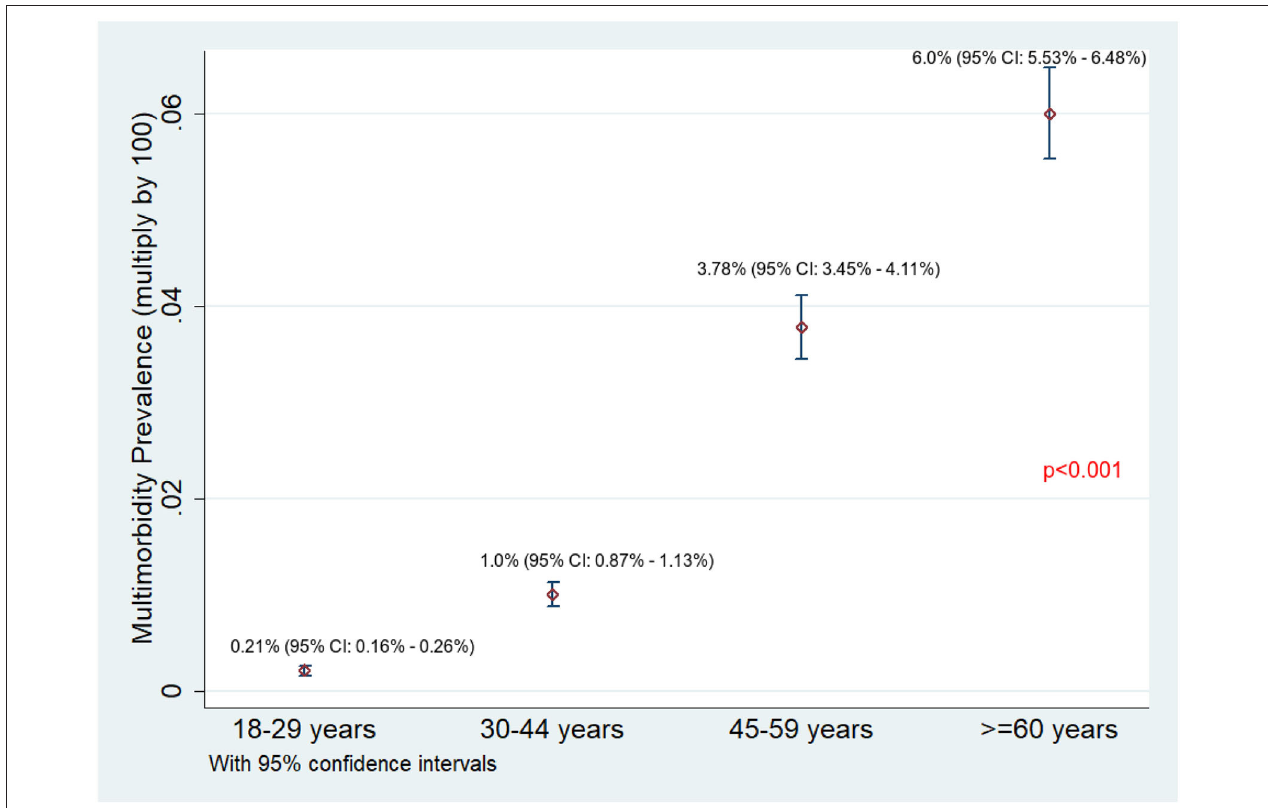
FIGURE 1 | Prevalence of NCD multimorbidity across different age categories among adults residing in HDSS, Gorakhpur (overall, N = 75,037; 18–29 years, n = 29,048; 30–44 years, n = 23,551; 45–59 years, n = 12,929; ≥ 60 years, n = 9,509).